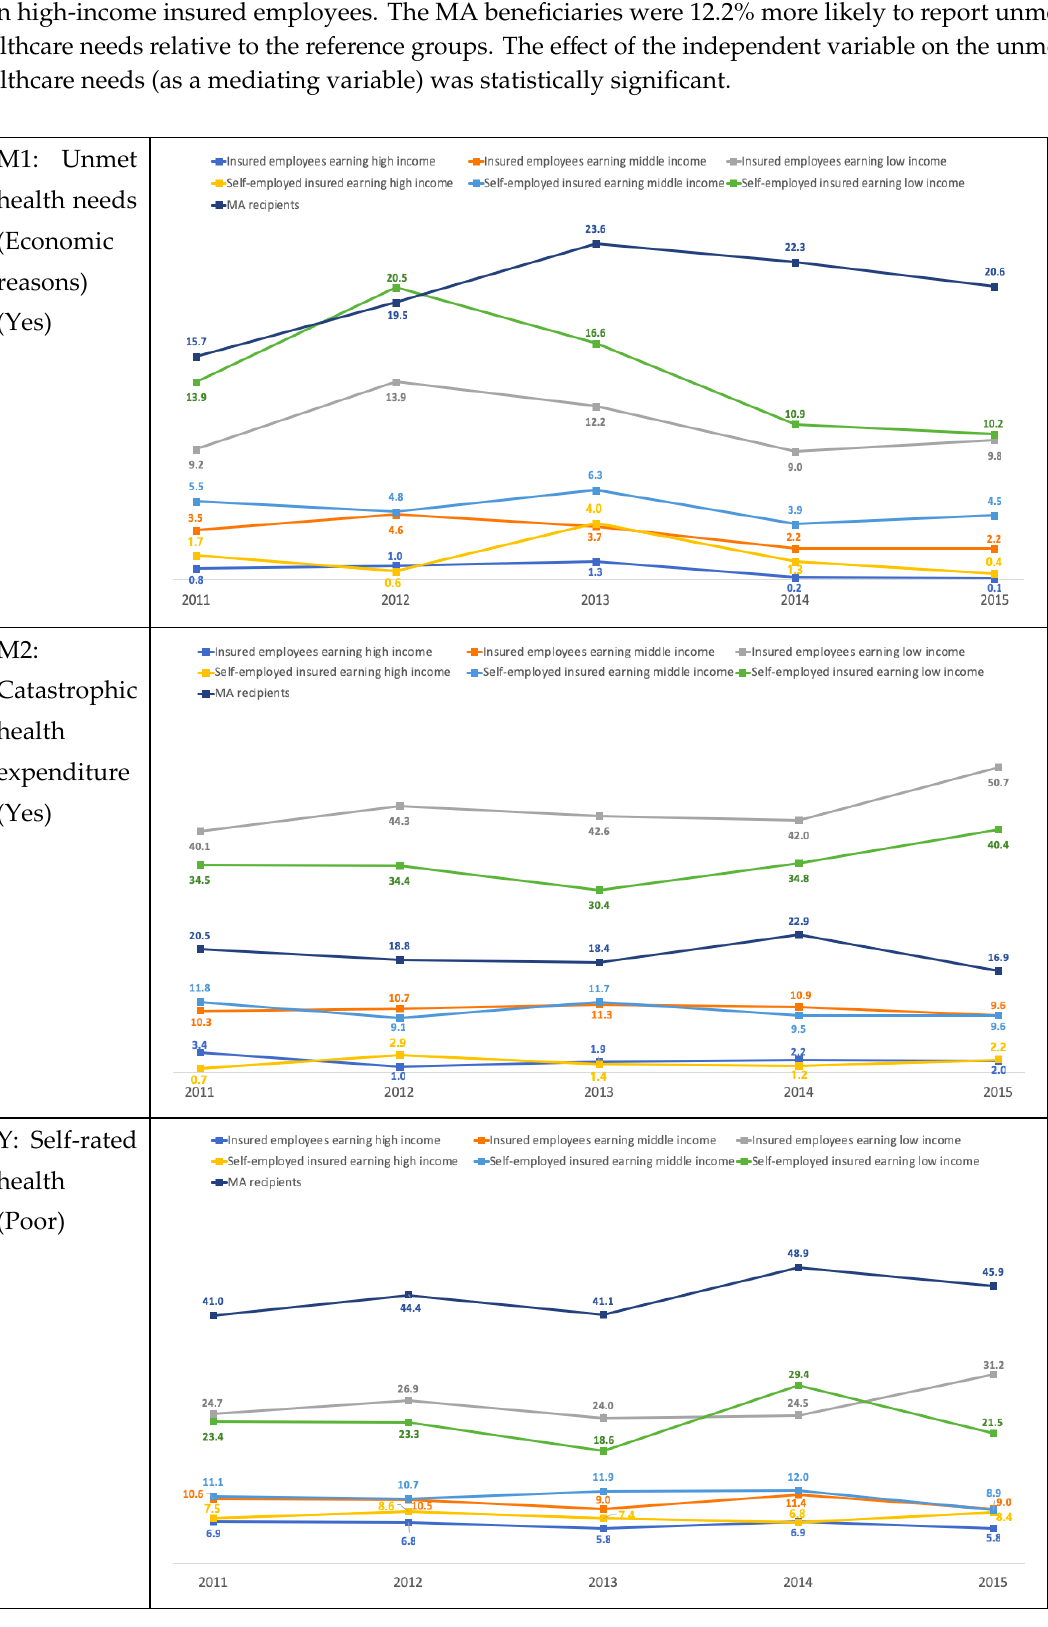
Figure 1. Proportion of participants reporting unmet healthcare needs, catastrophic health expenditure, and health status in South Korea from 2011 to 2015.